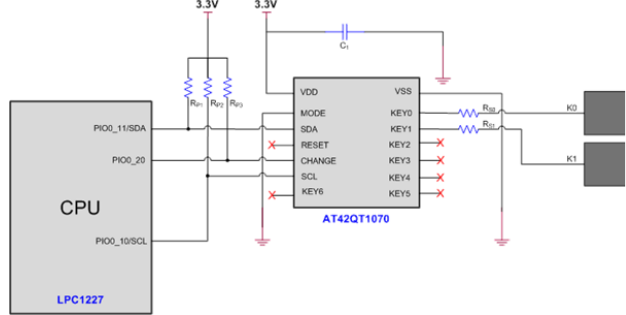
Fig. 7. Tactile interface solution with dedicated microcontroller and two tactile switch keys (K0 and K1).